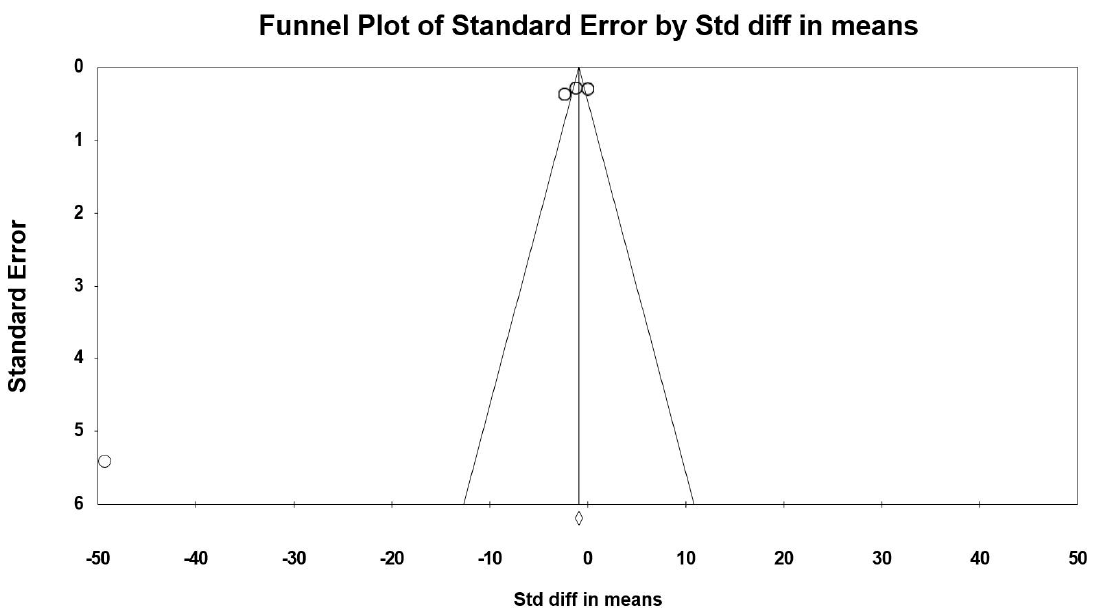
Figure 7. Funnel plot for MF showing evidence of publication bias.